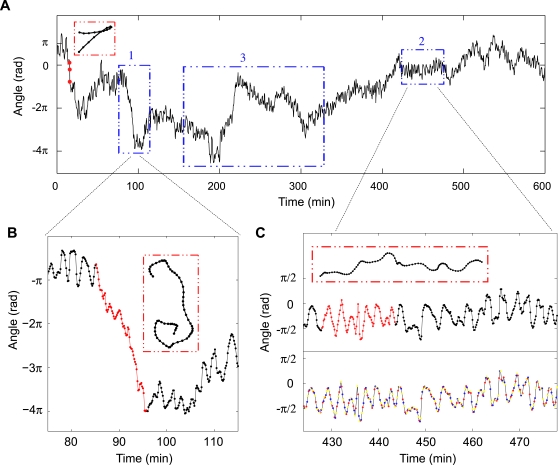
Cumulative angles.(A) Angles were corrected by +/−2π for changes larger than π. As shown by trajectories in red boxes, sharp turns correspond to large drops or rises; continuous turns in one direction appear as continuous drops or rises (box 1, enlarged view in B); and periods of directed motion are summarized as plateaus (box 2, enlarged view in C). On average, angles change but slowly with time. Box 3, see Fig. 8 caption. (B) Enlarged view of box 1 in A. The transition from 0 to −4π is continuous. (C) Enlarged view of box 2 in A. To reduce the influence of noise, angles were calculated at a larger τ (30 s) for most of the analyses. Thus from each trajectory, 3 interlaced time-series of angles were obtained. They are marked by different colors in the lower panel.